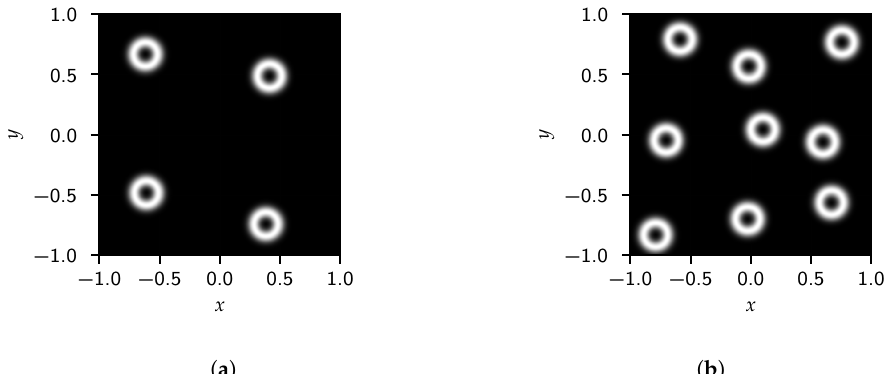
Figure 8. Generated images for the ( a ) four and ( b ) nine randomly placed circles with a radius of 0.1.